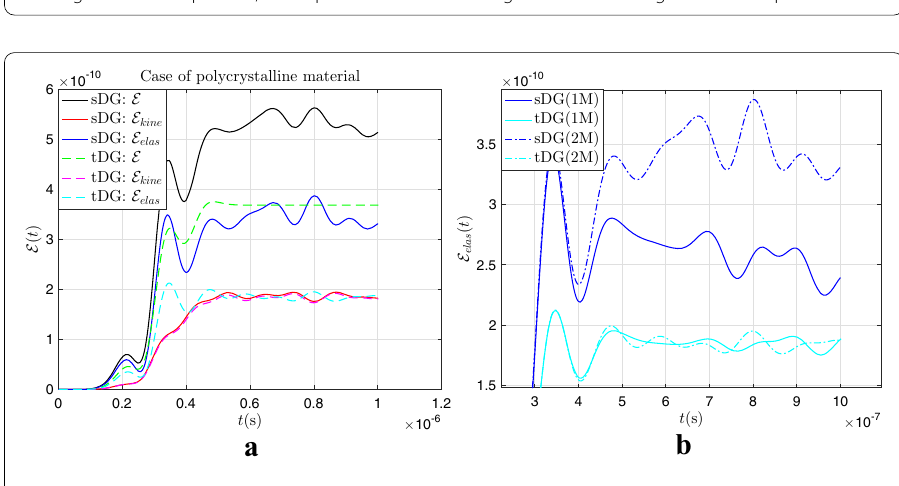
Fig. 7 Energy evolution over time. a Comparison between both space and time dG methods in the polycrystalline case; b comparison between monocrystalline and polycrystalline